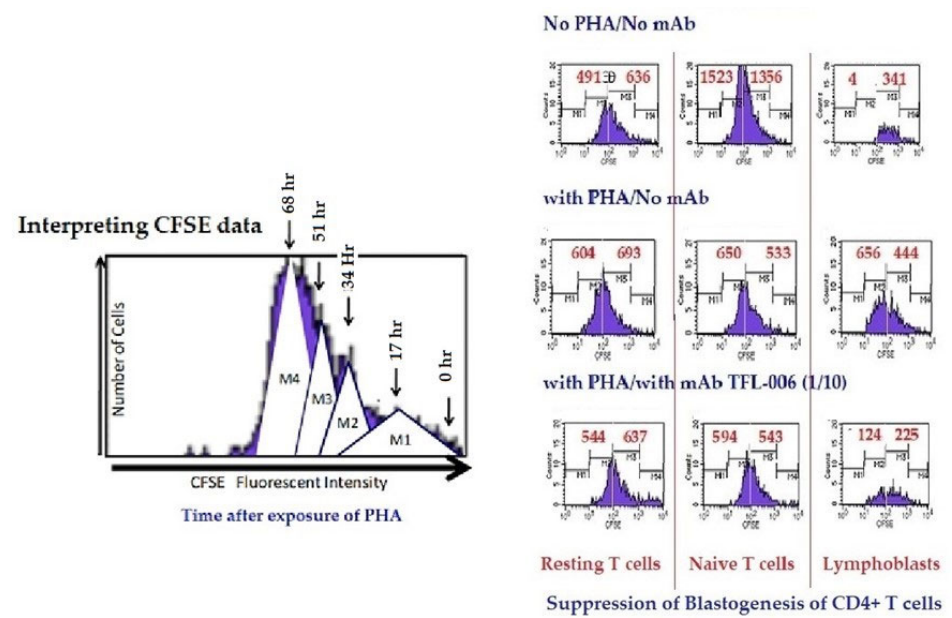
Figure 12. Suppression of in ‐ vitro proliferation of PHA ‐ activated CD4+ T lymphocytes by mAb TFL ‐ 006s (culture supernatant). The carboxyfluorescein succinimidyl ester (CFSE) ‐ labelled lymphocytes were cultured with or without PHA or with PHA and mAb TFL ‐ 006s at 1/10 dilution. Three days after culture, cells were labelled with fluorescent dye ‐ conjugated anti ‐ CD4+ or anti ‐ CD8+ Abs before analysis. CFSE labelling allowed us to gauge and show cell proliferation: when the CFSE ‐ labelled cell population undergoes mitosis, after 72 h it has migrated from the right to the left side of each rectangular box (as shown in the top figure) depending on the number of mitoses. The distance moved shows the number of cell divisions. The effects of mAb TFL ‐ 006s on the proliferation of CD4+/CFSE+ T lymphocytes are shown in each box. After incubating cells with CFSE, the cells were treated as noted. Each box in the figure is divided by a vertical line into two sub ‐ boxes, the right for mitoses 1 and 2 (M1/2) (parent lymphocytes) and the left for mitosis 3 to 5 (M3–5) (the progeny). The cell number after each treatment (including ‘no PHA’) of each T lymphocyte population was counted and compared, the number shown in each sub ‐ box. Note that with no PHA the number of cells in the M3–5 sub ‐ box is very meagre for all groups of CD4+ T lymphocytes. With PHA ‐ only treatment, the very high number of cells for M3–5 indicates that proliferation has occurred in all three groups. The impact of treatment with PHA and TFL ‐ 006s is striking: the number of cells in the